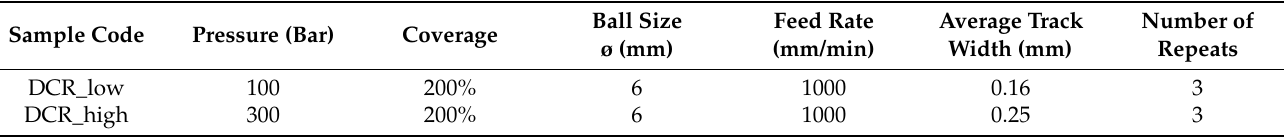
Figure 2. Images showing post ‐ processing by ( a ) DCR (deep cold rolling) and ( b ) CHP (controlled hammer peening). Table 2. Processing parameters used for deep cold rolling (DCR).